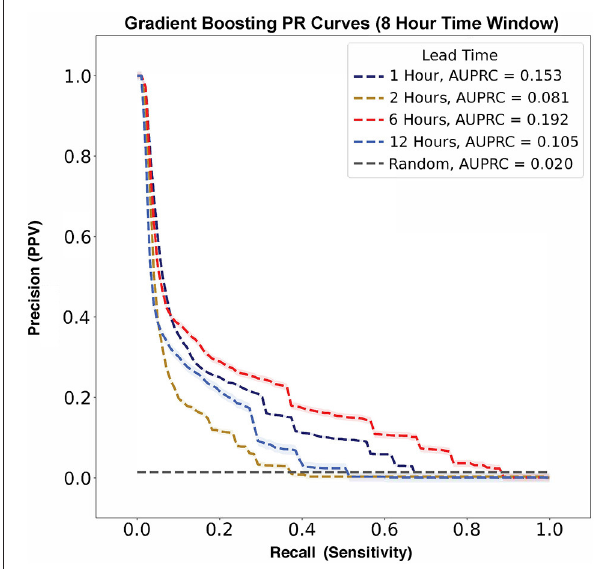
FIGURE 6 | Flow rate escalation precision-recall curves with shaded 95% confidence interval bounds for gradient boosting algorithms with a time window of 8h. The model has its largest AUPRC value of 0.192 at a lead time of 6h. There is not a clear trend between AUPRC and lead time. For reference, the prevalence of flow rate escalations in our model was 0.020, as represented by the gray no-skill classifier line.